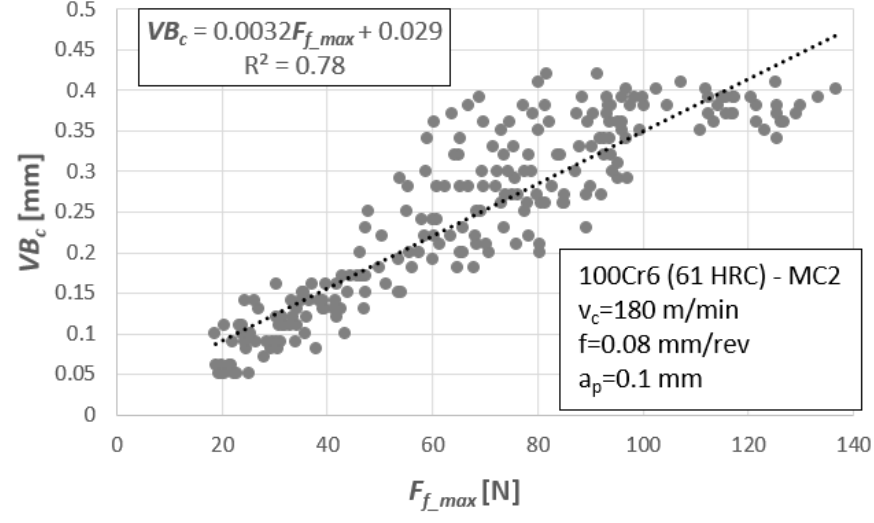
Figure 9. Diagnostic model in the form of a regression model for 15 tool tips .